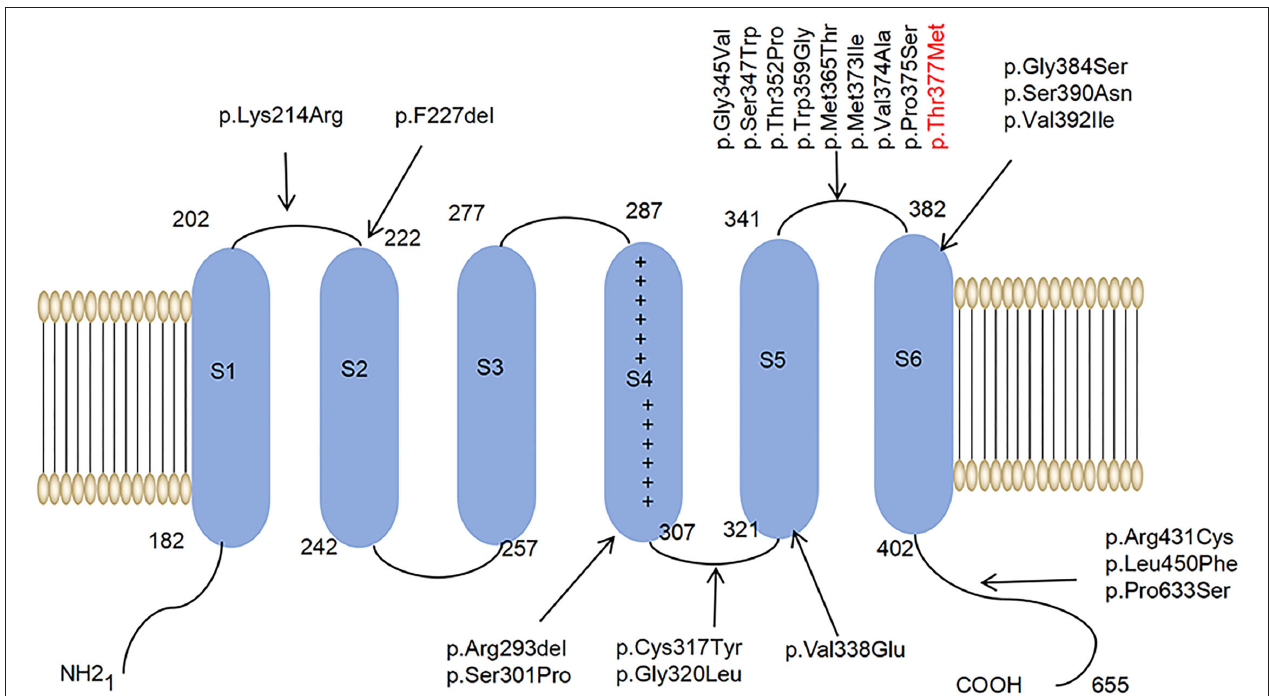
FIGURE 1 | A schematic diagram of the molecular structure of Kv4.3. A Kv4.3 subunit containing six transmembrane segments (S1–S6). The arrows indicate that 22 variants have been reported